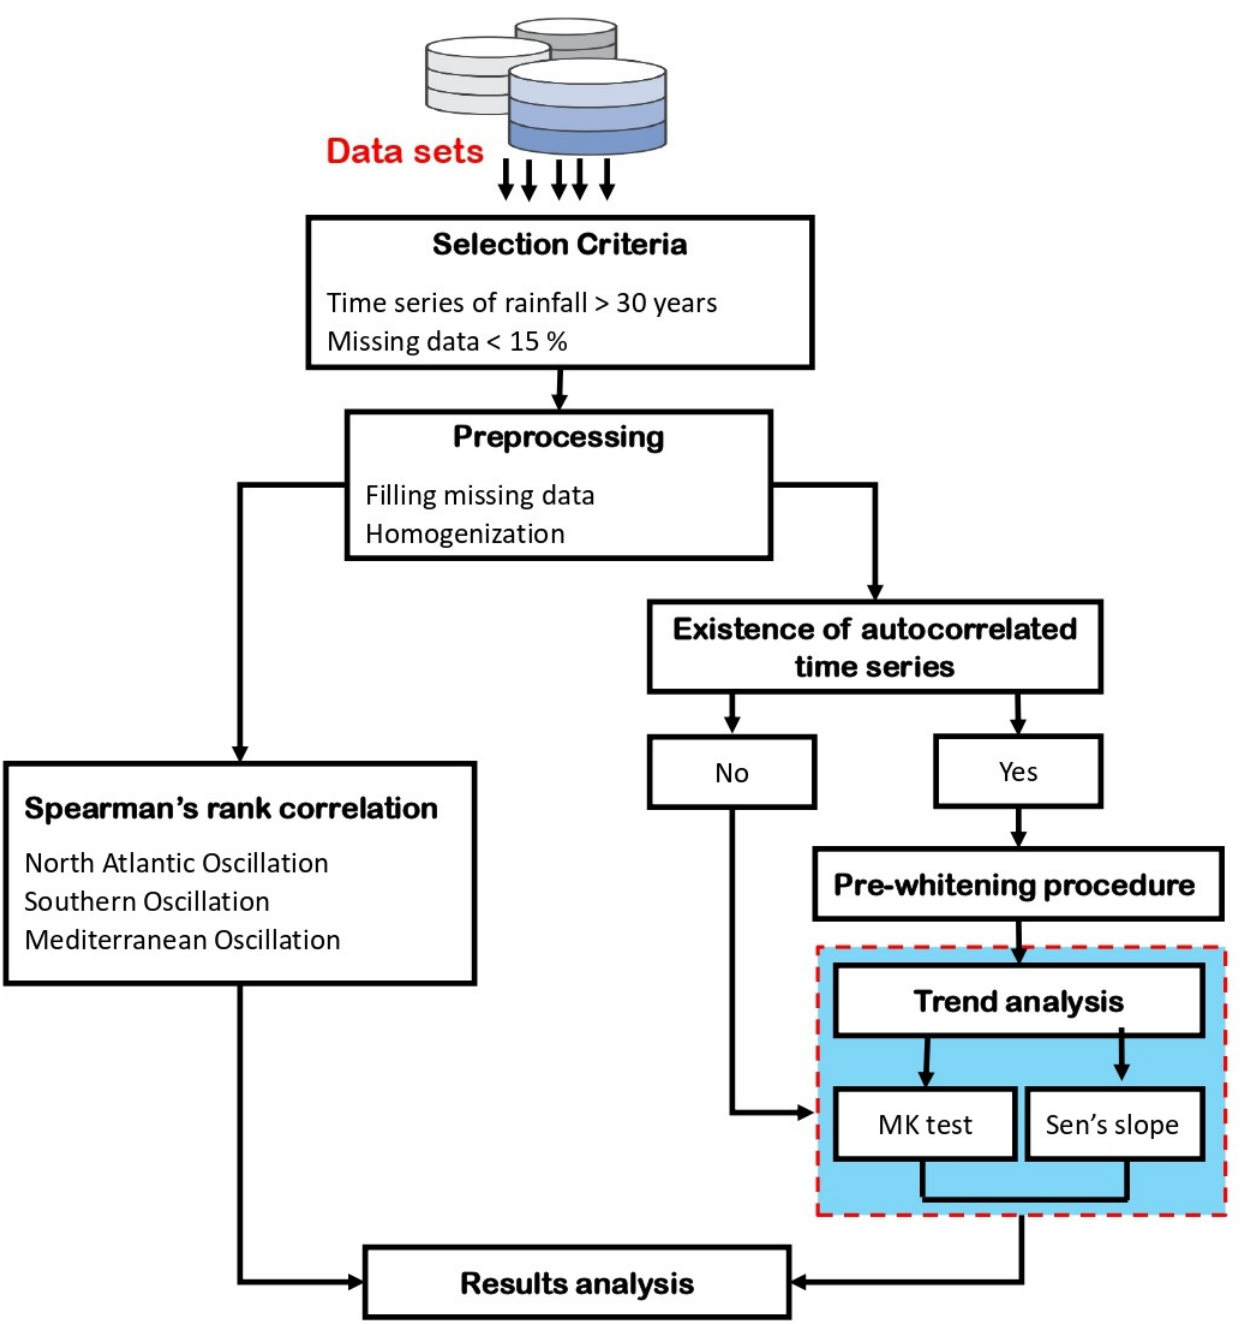
Figure 2. Flowchart of the methodology used in this study.